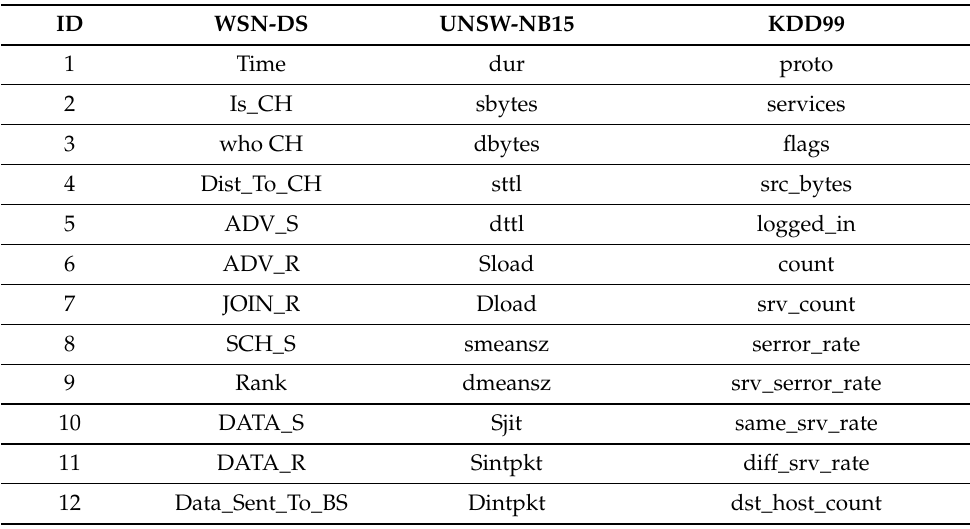
Figure 9. Feature importance of KDD99. Table 2. Feature